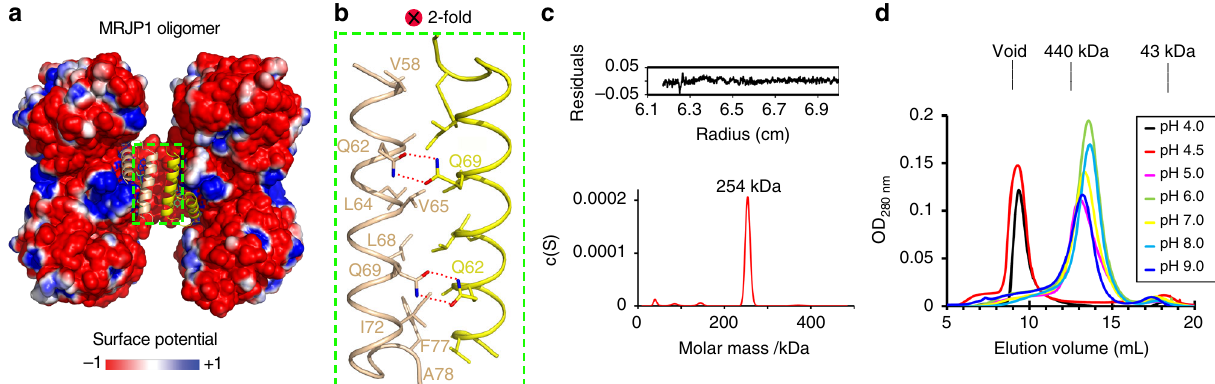
Fig. 6 Structural basis of the formation of the MRJP1 oligomer. a The surface potential (±1 kBT/e) of the MRJP1 oligomer. The surface coloured as a gradient ranging from red (negative) to blue (positive). Details of the interfaces between apisimin and the neighbouring symmetry-generated apisimin molecule are shown in b . Two apisimin protomers are related by a twofold rotation axis, perpendicular to the plane of the page. c Analytical ultracentrifugation of the MRJP1 oligomer at pH 8. The c(S) distribution from sedimentation velocity analysis is shown. d Gel fi ltration of the MRJP1 oligomer at different pH values